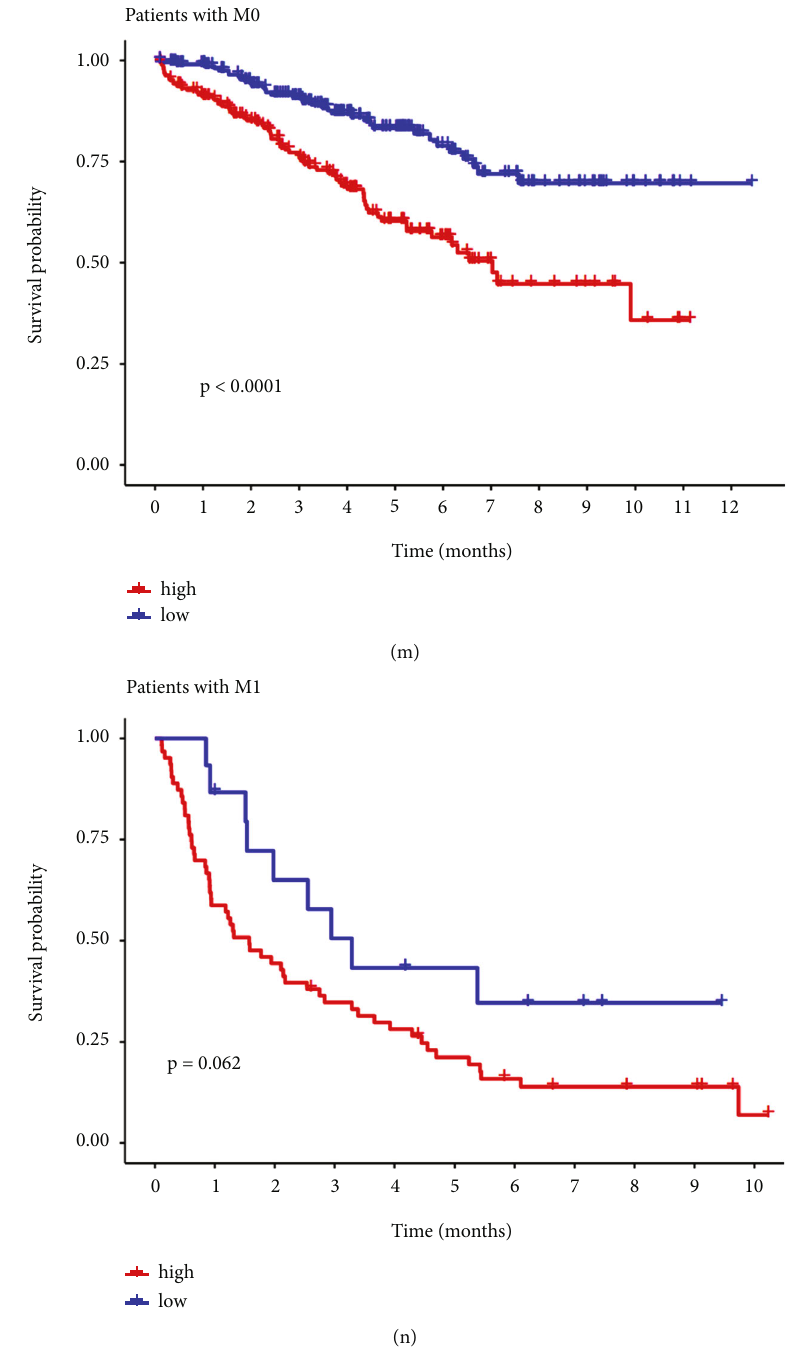
Figure 4: Subgroup analysis of risk characteristics. Subgroup analyses split by (a) and (b) age; (c) and (d) gender; (e) and (f) pathological grade; (g) and (h) stage; (i) and (j) tumor stage; (k) and (l) node stage; and (m) and (n) metastasis